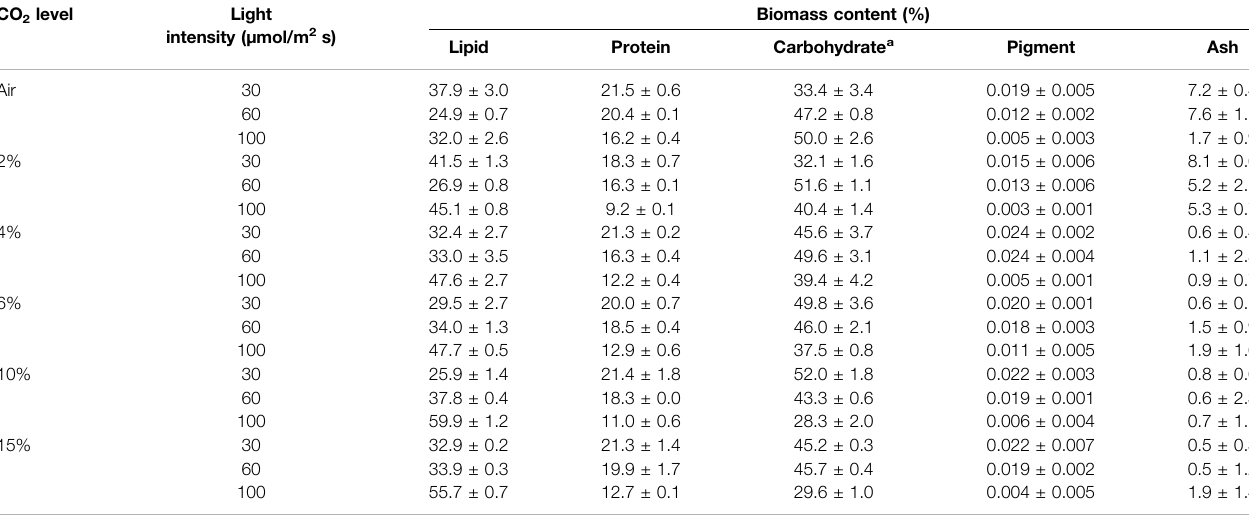
TABLE 1 | Biochemical composition of microalgae biomass under different light and CO 2 conditions. CO 2 level